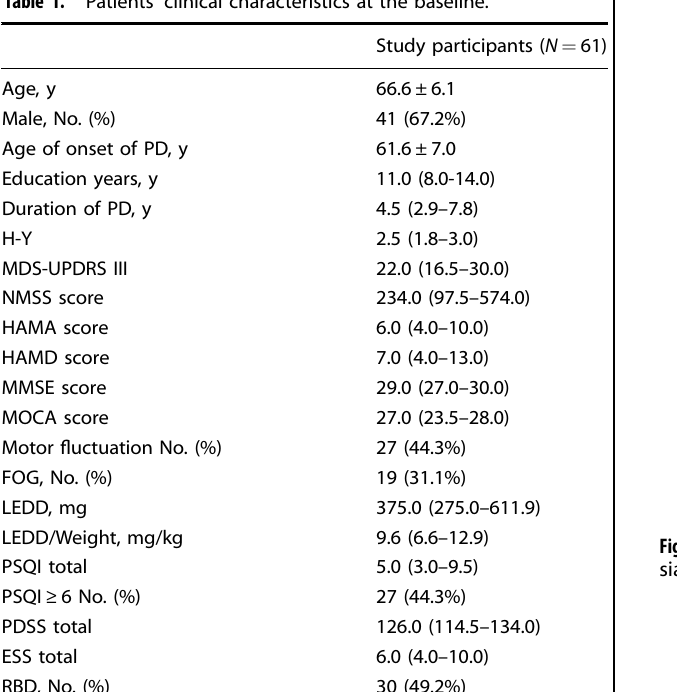
Table 1. Patients ’ clinical characteristics at the baseline.